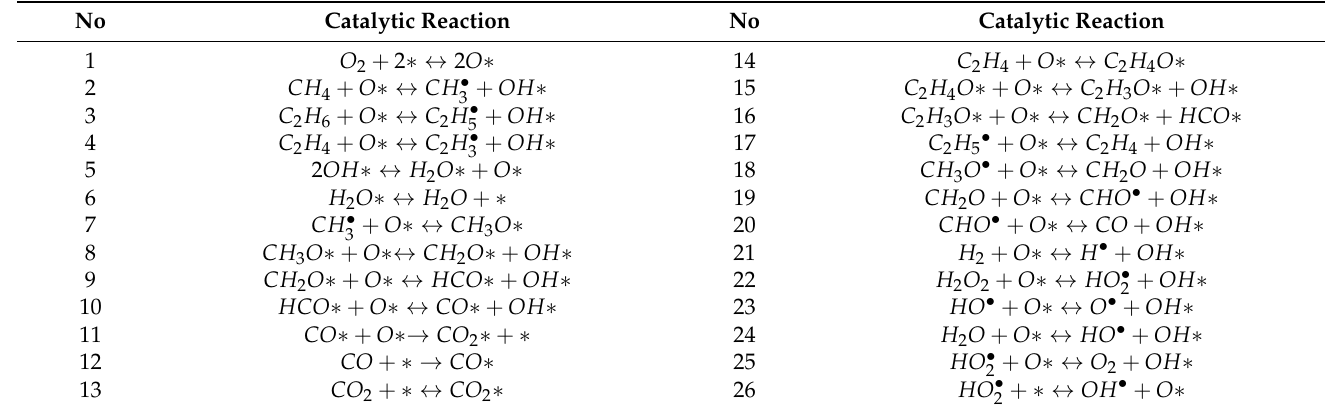
Table 5. Catalytic surface reaction steps as proposed by Kechagiopoulos et al.